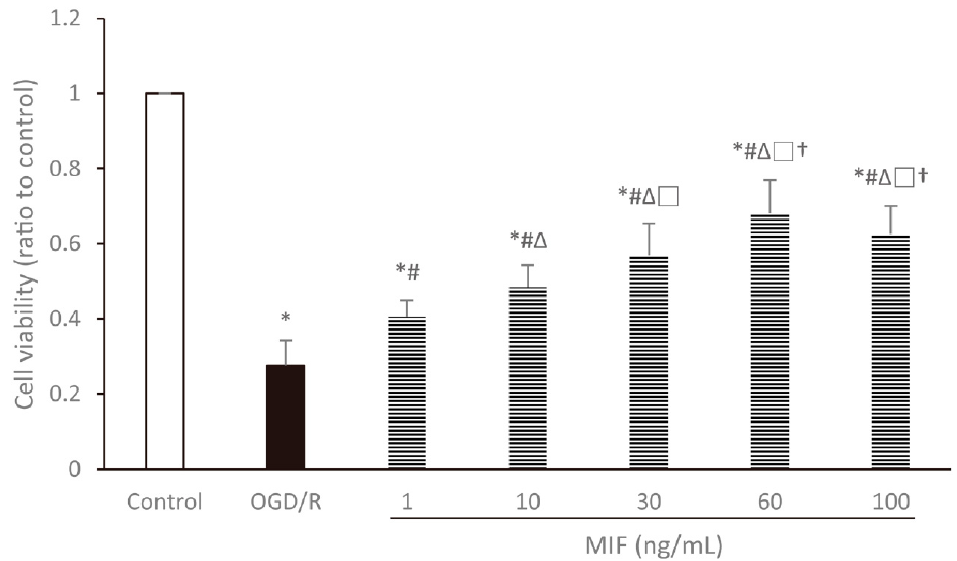
Figure 2. Cell viability assessed by water-soluble tetrazolium salt-1 (WST-1) assay relative to the control group. Cell viability was significantly increased in the MIF groups compared with the OGD/R group and peaked in the 60 ng/mL MIF group. Mean ± SD values from 24 independent experiments are presented. * p < 0.05 vs. control; # p < 0.05 vs. OGD/R group; ∆ p < 0.05 vs. 1 ng/mL MIF group; (cid:3) p < 0.05 vs. 10 ng/mL MIF group; † p < 0.05 vs. 30 ng/mL MIF group. Differences between groups were analyzed using one-way ANOVA followed by Tukey’s post hoc